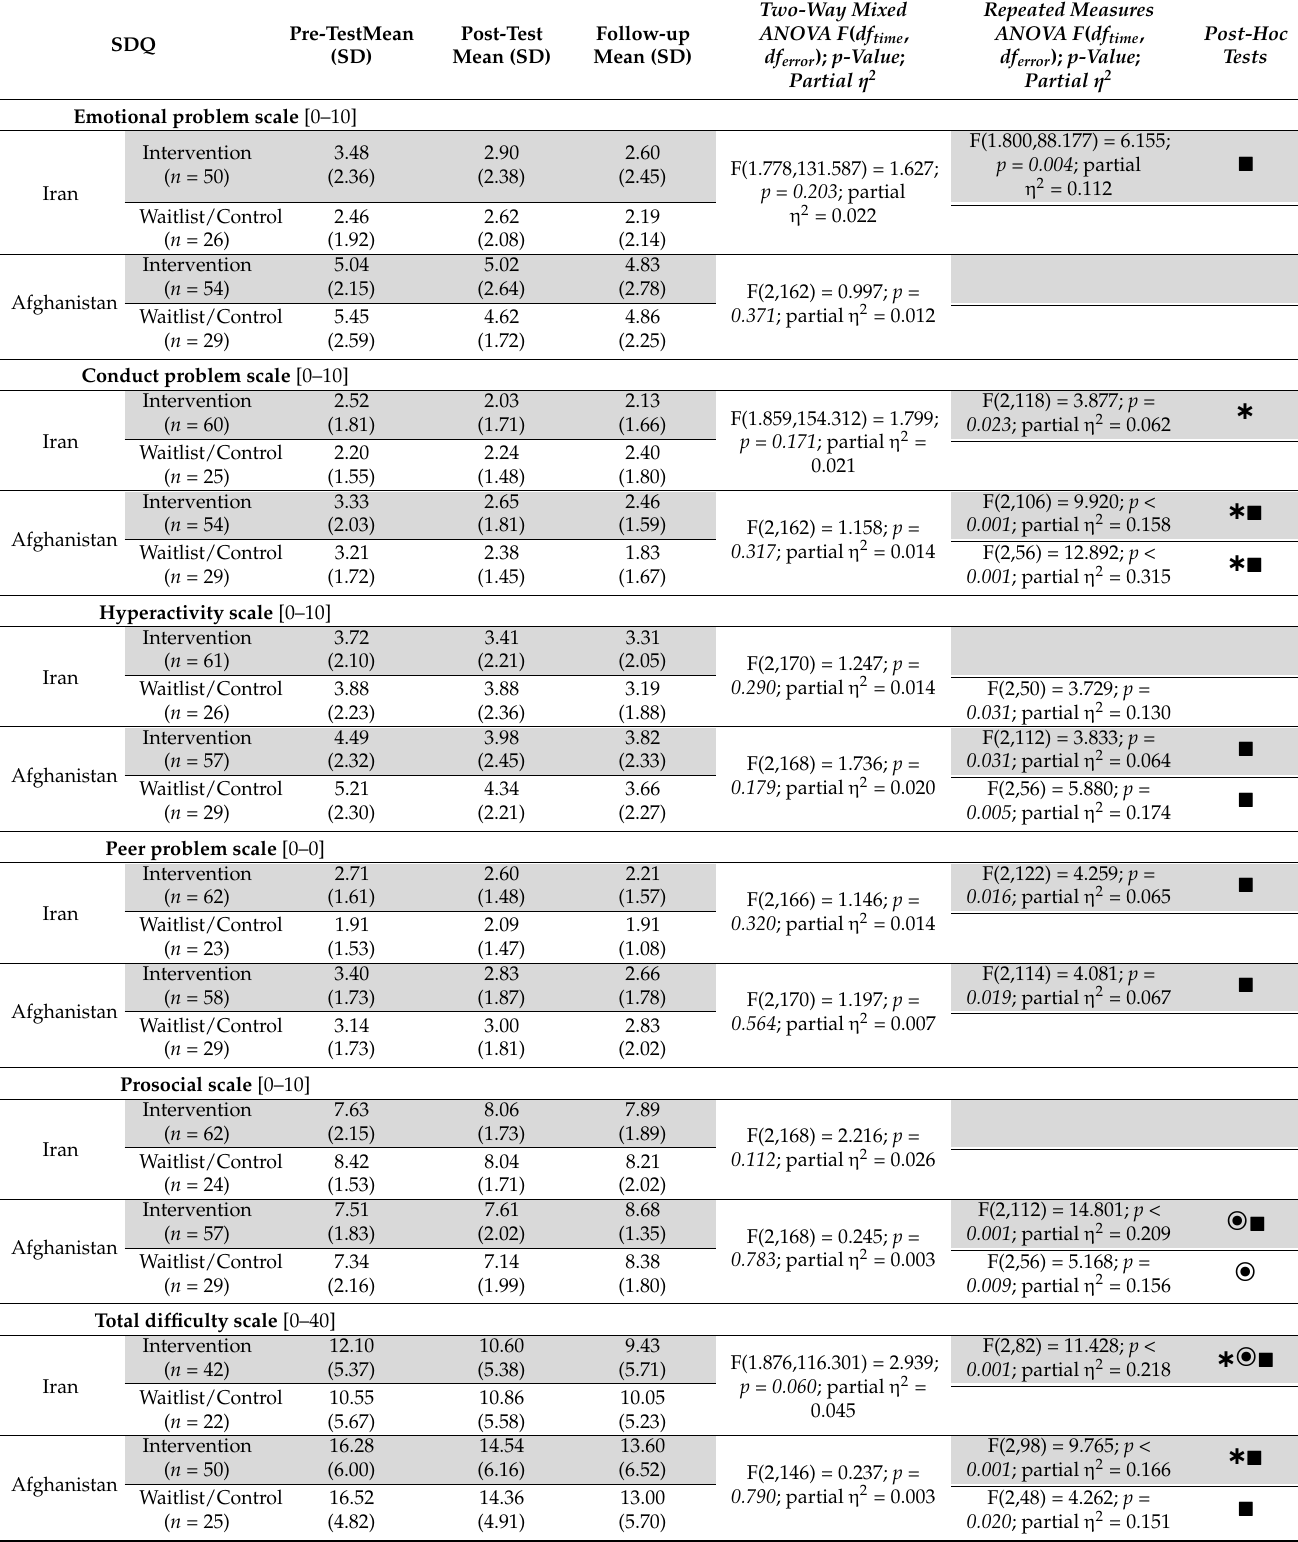
Table A5. Mean SDQ scores over time for families originating from Iran or Afghanistan by intervention or waitlist/control group. ( Higher scores indicating higher levels of difficulties on all subscales and the Total Difficulty Scale, except for the prosocial scale where higher scores indicate fewer difficulties in prosocial behaviour ).